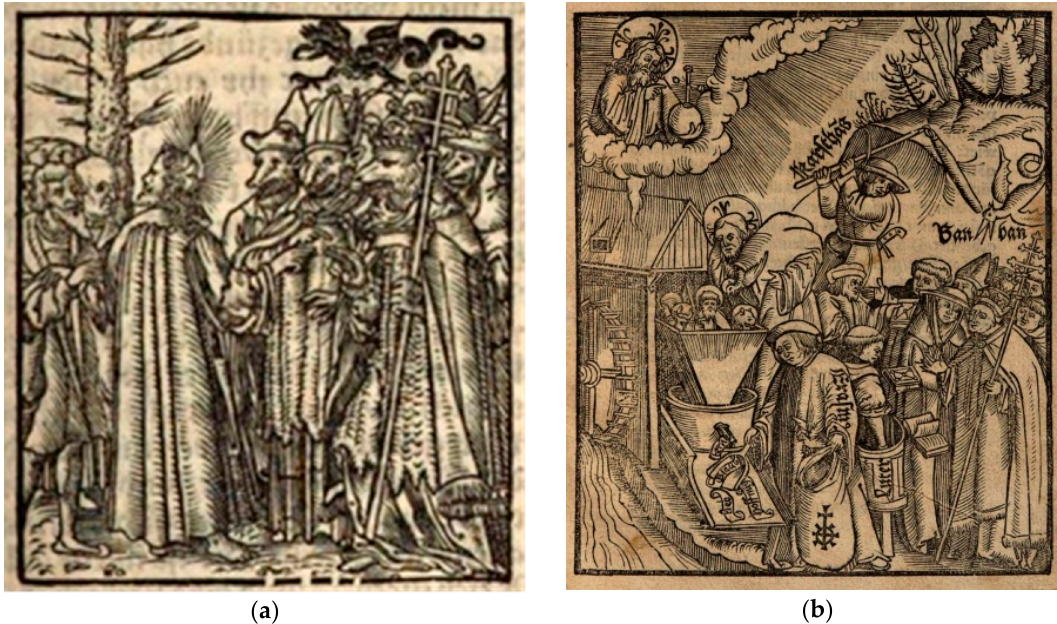
Figure 6. ( a ) Warning against false prophets [S 41], woodcut recurring in books published by vom Berg and Neuber, in (Luther 1544b, fol. CLXXX) (Munich, Bayerische Staatsbibliothek, 2 Hom.